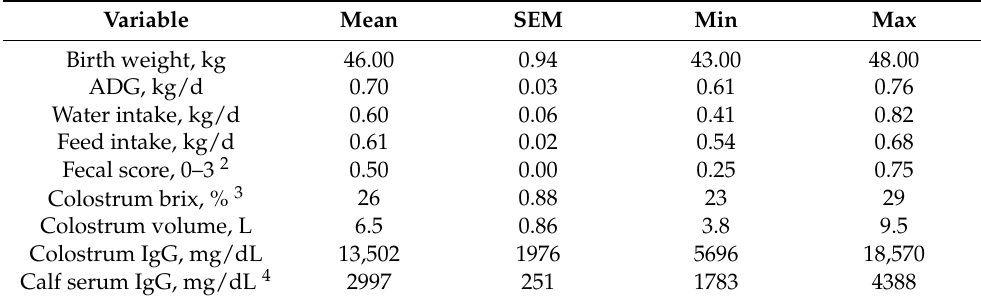
Table 1. Descriptive statistics for Holstein calves and colostrum 1 during experiment.